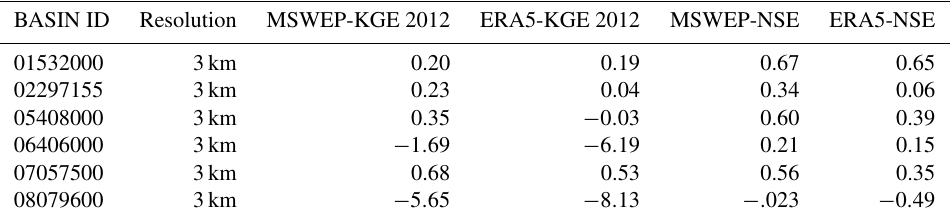
Table A1. Evaluation period results. Comparison of evaluation period objective function results of the 3km wflow_sbm instance based on the ERA5 and MSWEP forcing data